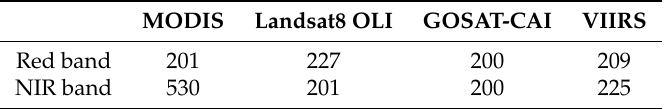
Table 6. SNR in the red and NIR bands for the Aqua-Moderate Resolution Imaging Spectroradiometer (Aqua-MODIS) [38], Landsat 8-Operational Land Imager (Landsat 8 OLI) [39], Greenhouse Gases Observing Satellite (GOSAT)-Cloud and Aerosol Imager (CAI) [40], and Suomi National Polar-orbiting Partnership (NPP)-Visible Infrared Imaging Radiometer Suite (VIIRS) [41]. SNR for MODIS band1 (red) was derived by calculating 128 (sensor design requirement) × 1.57 (ratio of measured SNR in-orbit to sensor design requirement) and SNR for MODIS band 2 (NIR) was derived by 201 × 2.64 [38]. Similaly, SNR for VIIRS I1 and I2 bands (red and NIR) were derived by caluculating 119 × 1.76 and 150 × 1.5, respectively